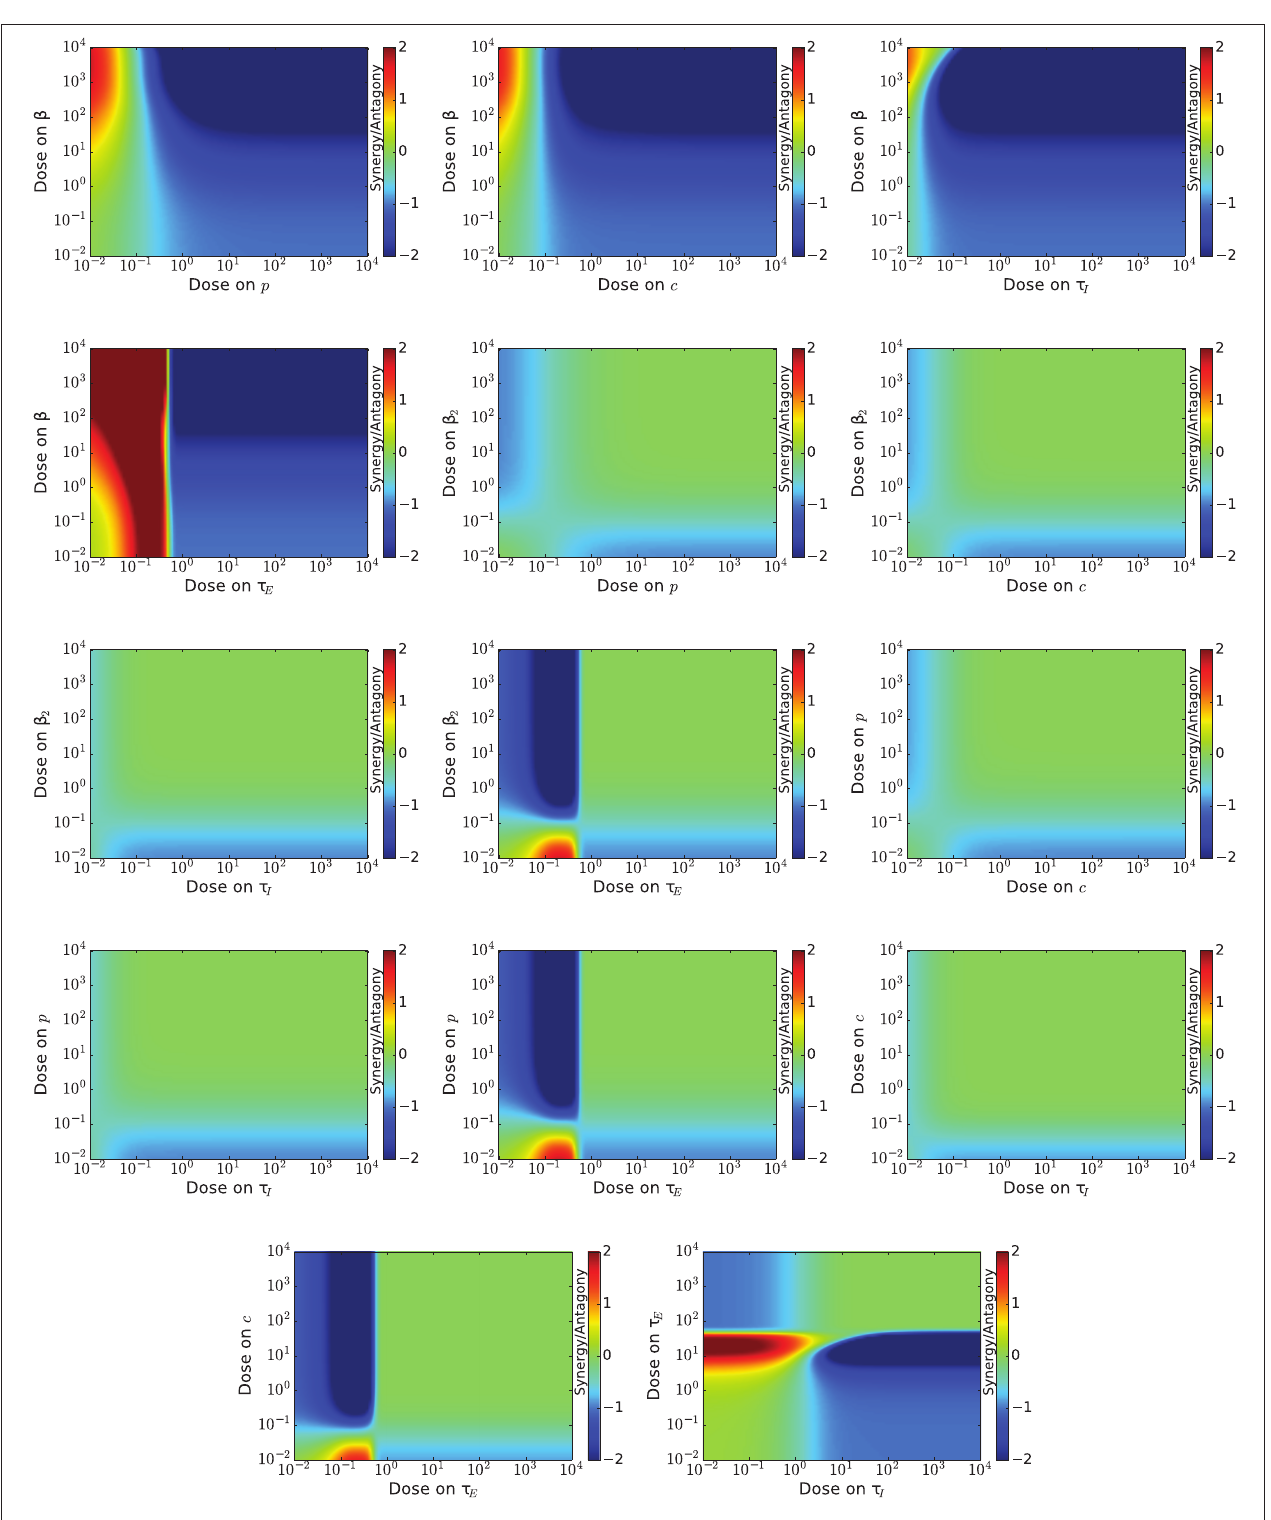
FIGURE 4 | Synergy for a range of doses of various combinations of influenza antivirals. Antagony of the antivirals is indicated by regions of blue, while regions of synergy are indicated by red. Note that most combinations result in neither synergy nor antagony (pale green).